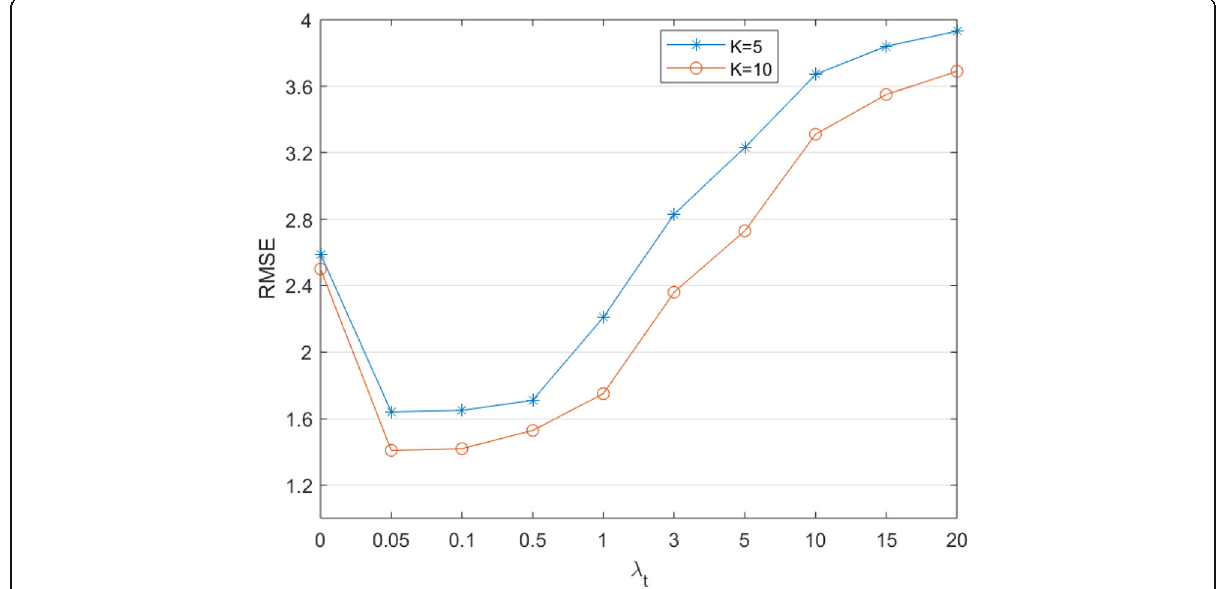
Fig. 6 RMSE vs. λ t on Epinions. The blue line with K = 5, and the green line with K =